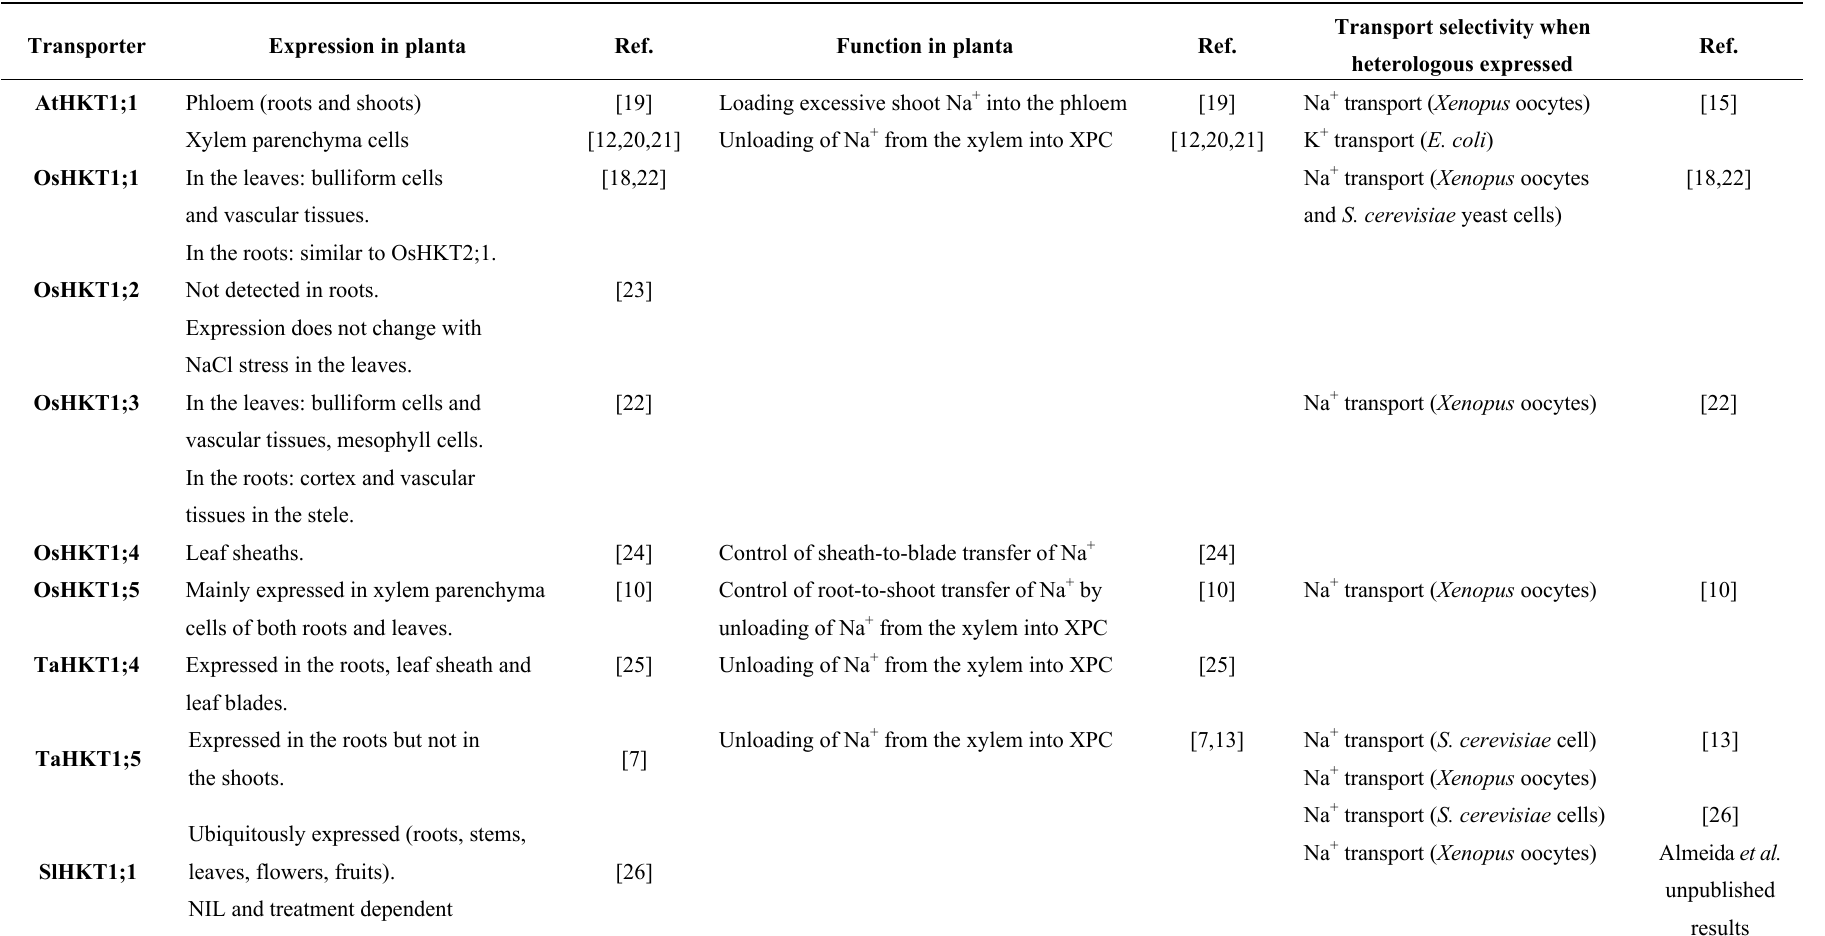
Table 1. List of all HKT1 transporters isolated and